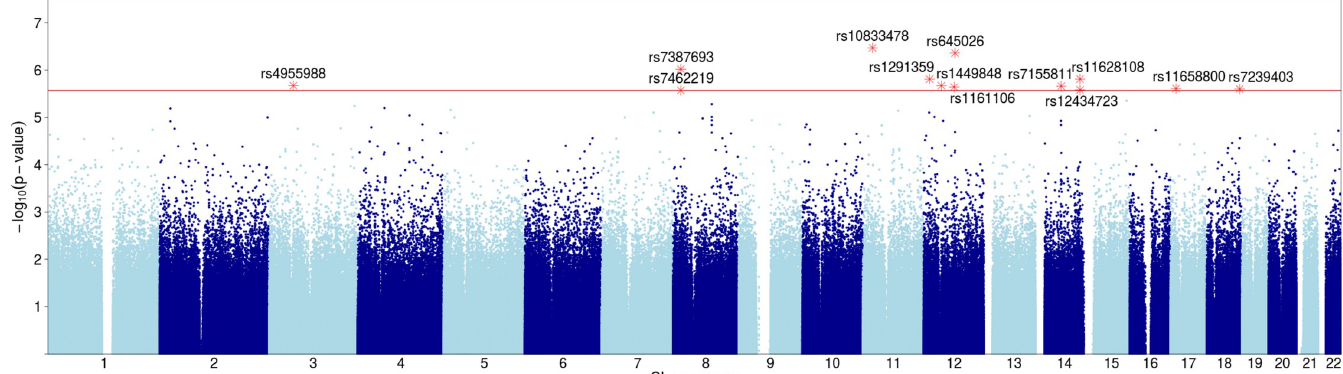
Fig 1. Manhattan plot of SNPs with Bayley phenotype dependence. Y axis shows p-values (negative log scale) of pairwise dependence of SNPs with Bayley phenotypes at 24 months (see Table 2). SNPs with p-value < 2.7x10 -6 (red line) are highlighted and labeled.